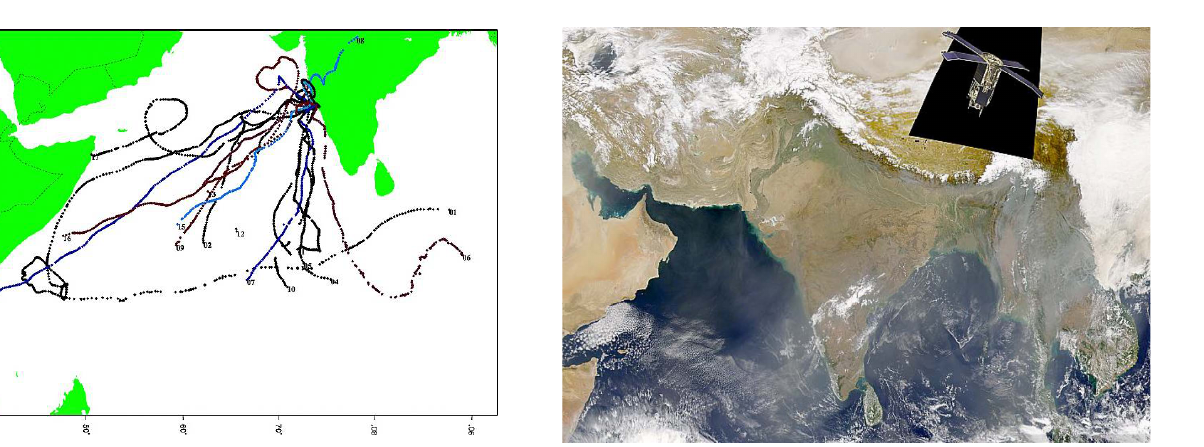
Fig. 9. Satellite image of the SAW-ABC, showing a composite over several days in March, 1999, during the INDOEX campaign (Pro- vided courtesy of the SeaWiFS Project, the NASA/Goddard Space Flight Center and